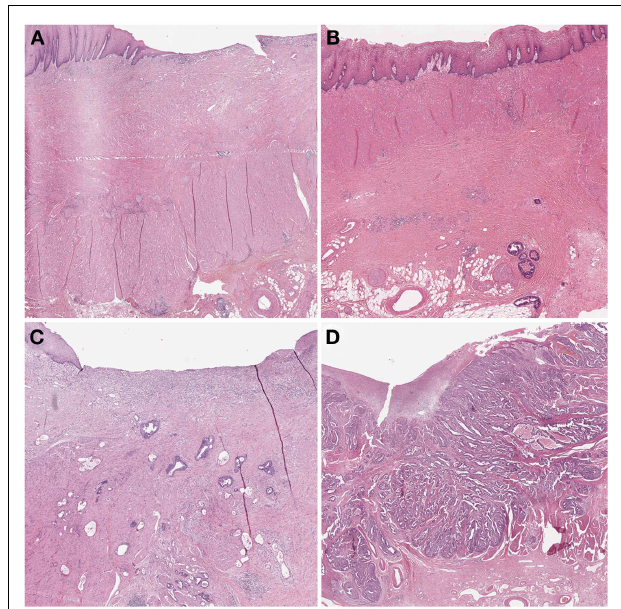
FIGURE 3 | Examples of tumor regression grades according to Becker . (A) TRG 1a complete regression.This image would be classified asTRG 1 according to Mandard andTRG 4 according to Dworak. (B) TRG 1b < 10% residual tumor. MandardTRG would be 2, DworakTRG 3. (C) TRG 2 10–50% residual tumor. MandardTRG would be 3, but 2 could also be possible since there is no strict definition of “scattered tumor cells” and “preponderance of fibrosis”; DworakTRG would be 2: the term “scattered tumor cells” is by complemented by “histologically slightly recognizable.” (D) TRG 3 > 50% residual tumor. MandardTRG would be 4 or 5 and Dworak 0 or 1 since one can appreciate fibrotic stands which could be preexisting desmoplasia or